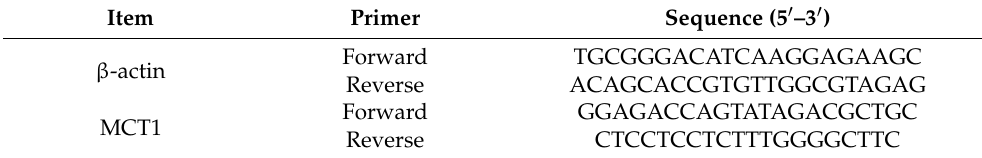
Table 4. Primer sequences for real-time polymerase chain reaction